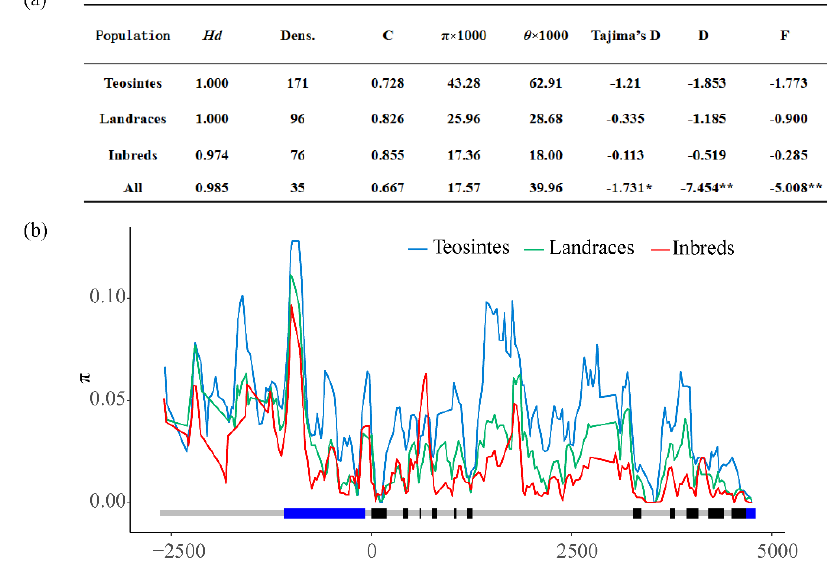
Figure 1. Nucleotide diversity (π) of inbred lines, landrace and teosinte. ( a ) Summary of nucleotide polymorphisms and neutrality test of ZmMADS60 , Hd represents haplotype diversity, Dens. Denotes number of single nucleotide polymorphisms (SNP) per 1000 bp, C represents sequence conservation, and D and F represent Fu and Li’s D *and F *. * indicates a statistical significance at p < 0.05 level, ** indicates a statistical significance at p < 0.01 level ( b ) Nucleotide diversity (π) of inbred lines, landraces, and teosinte. π was calculated using the sliding windows method with a window size of 100 bp and a step length of 25 bp. A schematic diagram of the genomic region of ZmMADS60 , including upstream sequence and introns ( light gray ), the coding region ( black ), and 5’ UTR and 3’UTR ( blue ) is presented.